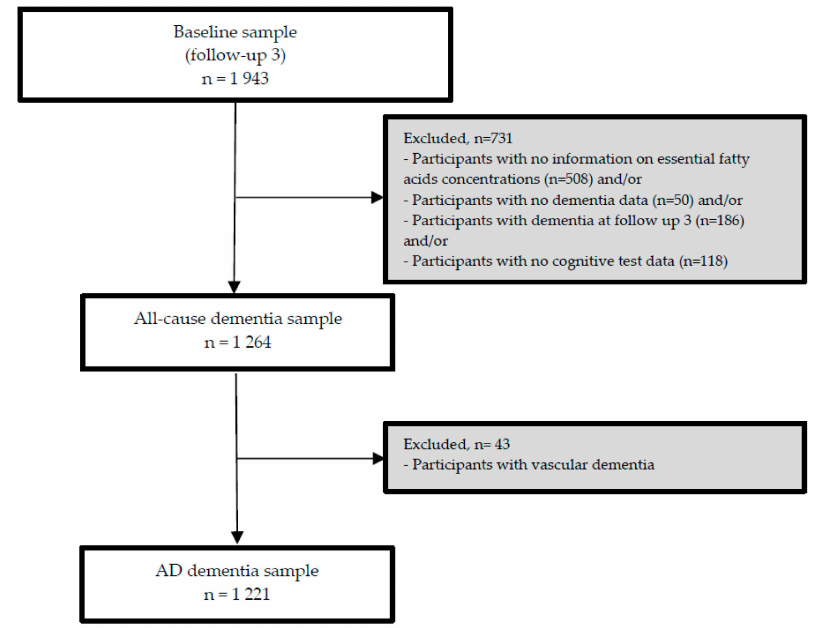
Figure 1. Flow chart of the participants included in the